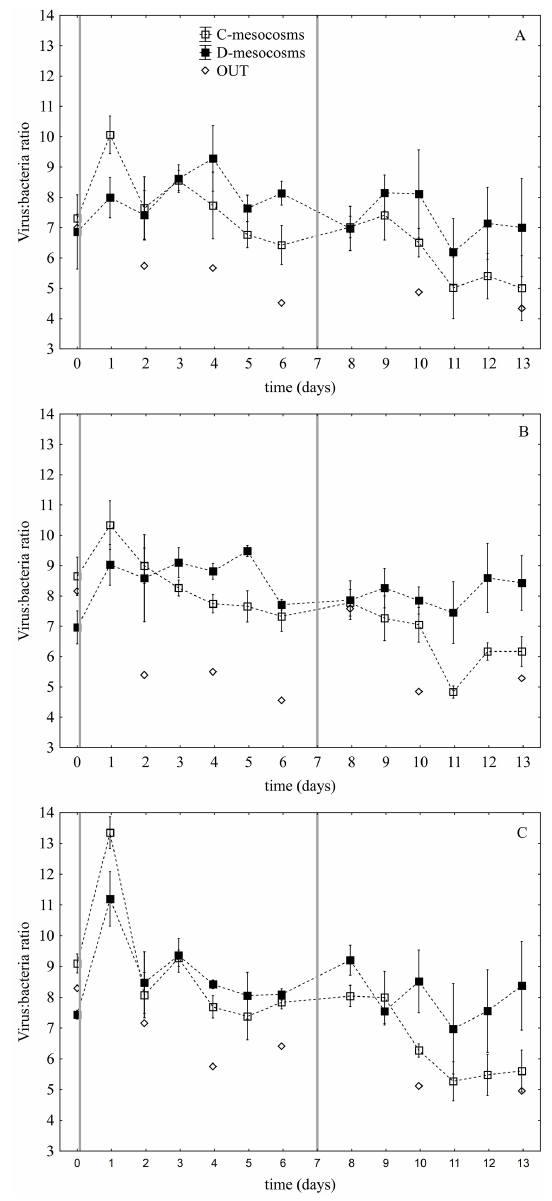
Figure 8. Heterotrophic nanoflagellate abundance (cell mL − 1 , mean ± standard deviation of three replicate mesocosms) in dust- and control-mesocosms and OUT samples at 5m depth during the DUNE-R experiment. Grey vertical bars represent the dust seed-